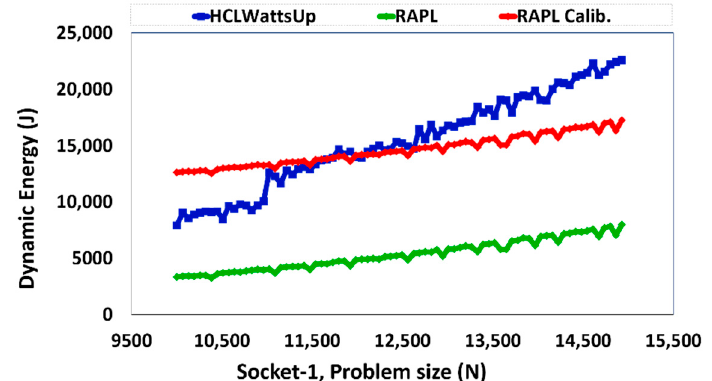
Figure 2. Dynamic energy consumption profile segments of matrix-matrix multiplication using Intel Math Kernel Library (MKL) constructed with HCLWattsUp and Intel Running Average Power Limit (RAPL) on HCLServer01.